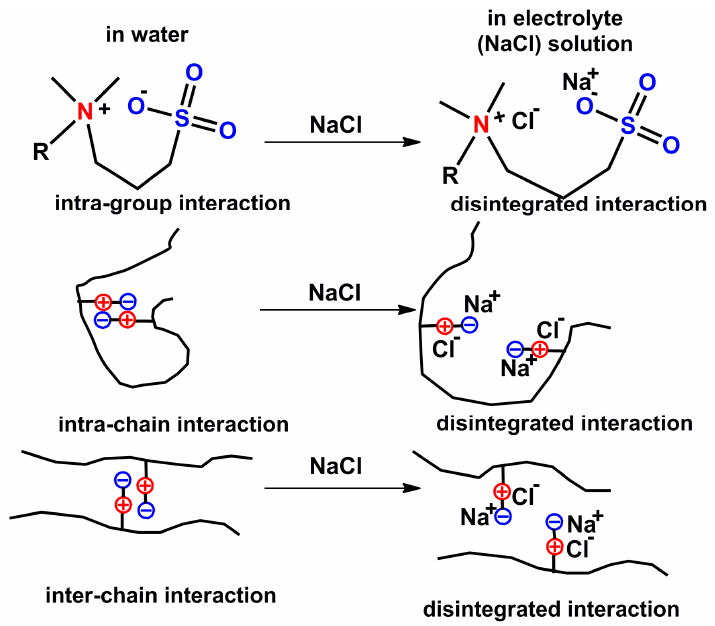
Figure 4. Proposed mechanism for antipolyelectrolyte effect on polyzwitterion structure by simple electrolyte.